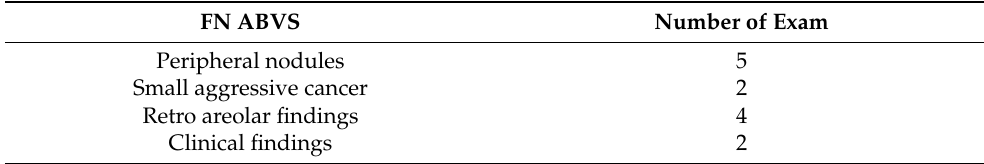
Table 2. Main reasons for false-negative ABVS